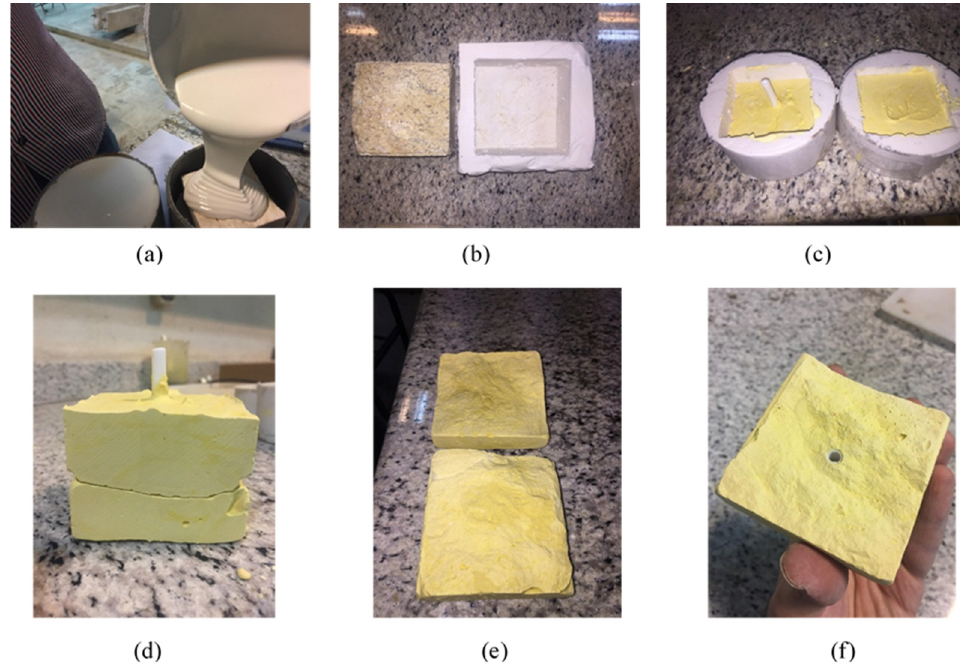
Figure 1. Fabricating rock joint replicas in this study: ( a ) Molding process; ( b ) Comparison of the mold produced and the rock joint; ( c ) Casting dental plaster replicas; ( d ) Complete matching in joint planes; ( e ) Surface roughness captured; ( f ) Placement of the pipe in the samples for grouting procedure.